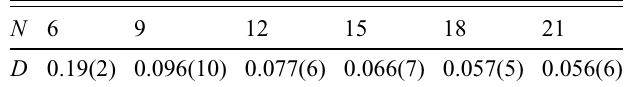
TABLE I. The average distance from the long-time system-of- interest state to the grand canonical state, ρ GC , when only energy are conserved. Each nearest-neighbor pair in the ion and σ tot z chain forms a small system of interest. The long-time state of the pair lies some distance from ρ GC (the most accurate thermal prediction). We measure this distance using the relative entropy D [8], measured in nats. Then, we average over the pairs in the chain. The average pair thermalizes more thoroughly than if noncommuting charges are conserved, at all global system sizes N